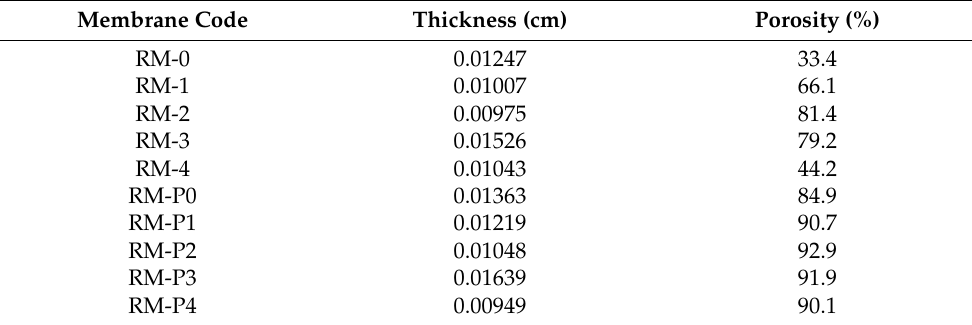
Figure 8. FESEM cross-sections for ( A ) pure PPSU membrane, ( B ) with 0.05% GO-WO 2.89 /PPSU, ( C ) with 0.1% GO-WO 2.89 /PPSU, ( D ) with 0.15% GO-WO 2.89 /PPSU, ( E ) with 0.2% GO-WO 2.89 /PPSU ( F ) PPSU/PVP membrane, ( G ) with 0.05% GO-WO 2.89 /PPSU/PVP, ( H ) with 0.1% GO-WO 2.89 /PPSU/PVP, ( I ) with 0.15% GO-WO 2.89 /PPSU/PVP, ( J ) with 0.2% GO-WO 2.89 /PPSU/PVP. Table 3. The thickness and the porosity of the membrane. Membrane Code Membrane